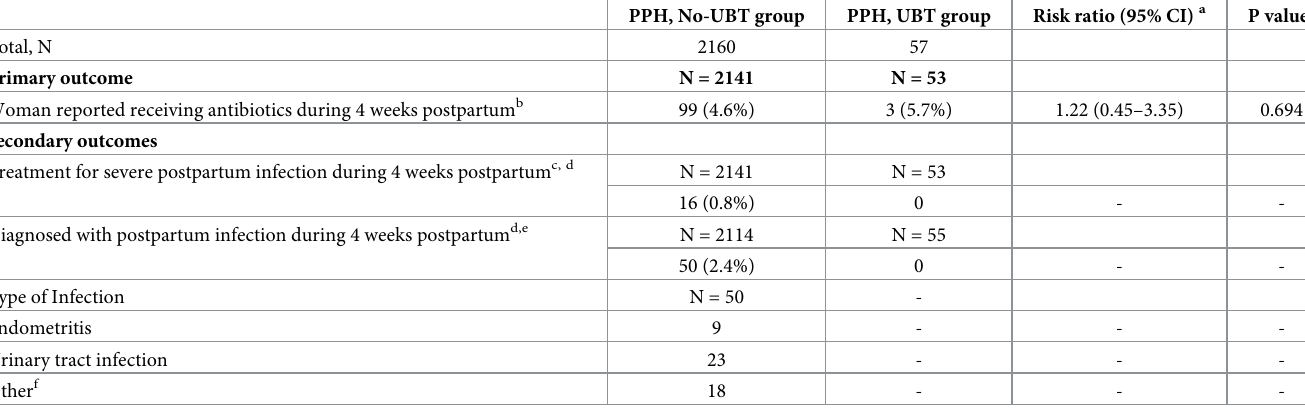
Table 3. Self-reported postpartum infection during the 4-week postpartum follow-up